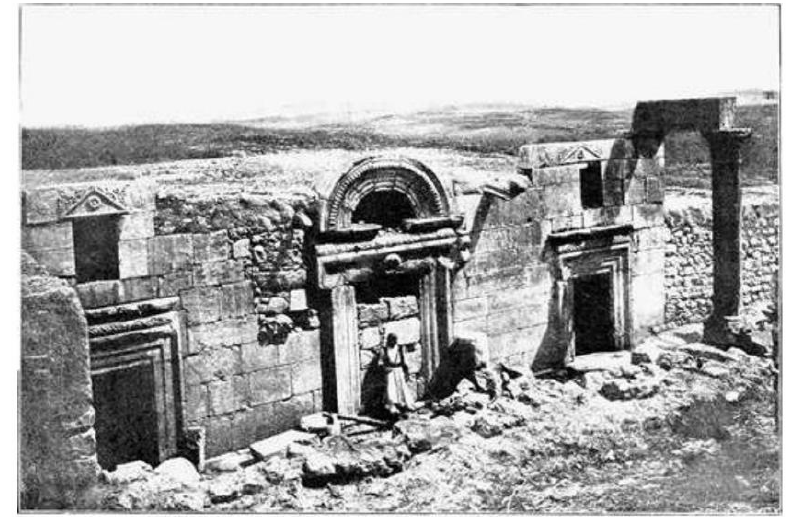
Figure 2. The large synagogue in Kfar Baram (Bacher and Dembitz 1905, p. 621).